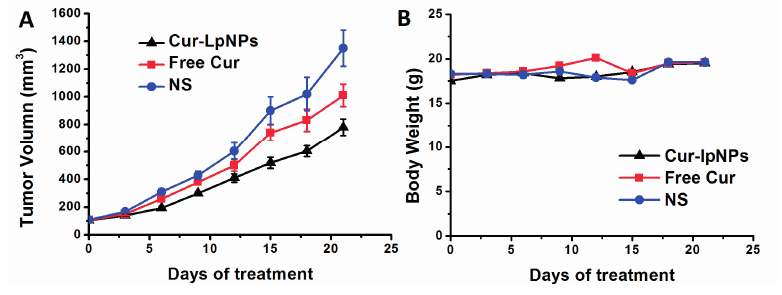
Figure 6. Effects of Cur–lpNPs treatment on primary tumor growth. ( A ) The mean tumor volumes ± SD of 8 mice per every group; ( B ) The mean mice weights ± SD of every